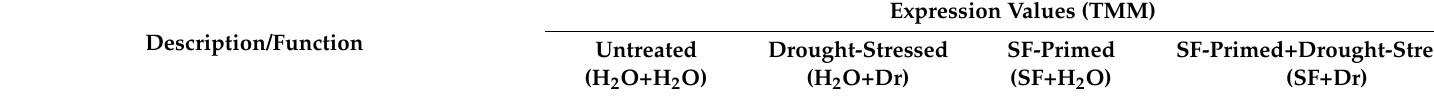
Table 1. Super Fifty and drought alter the expression of genes representing the activation of drought signaling pathways for stress tolerance. Values are trimmed means of M-values (TMMs) averaged across three biological replicates. Dr, drought stress; SF, Super